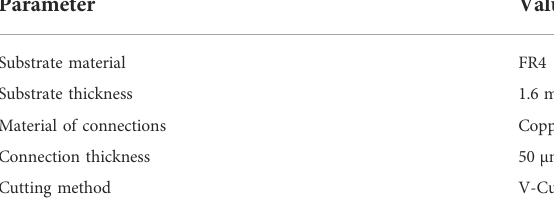
TABLE 1 Speci fi cations of SPE printed circuit board